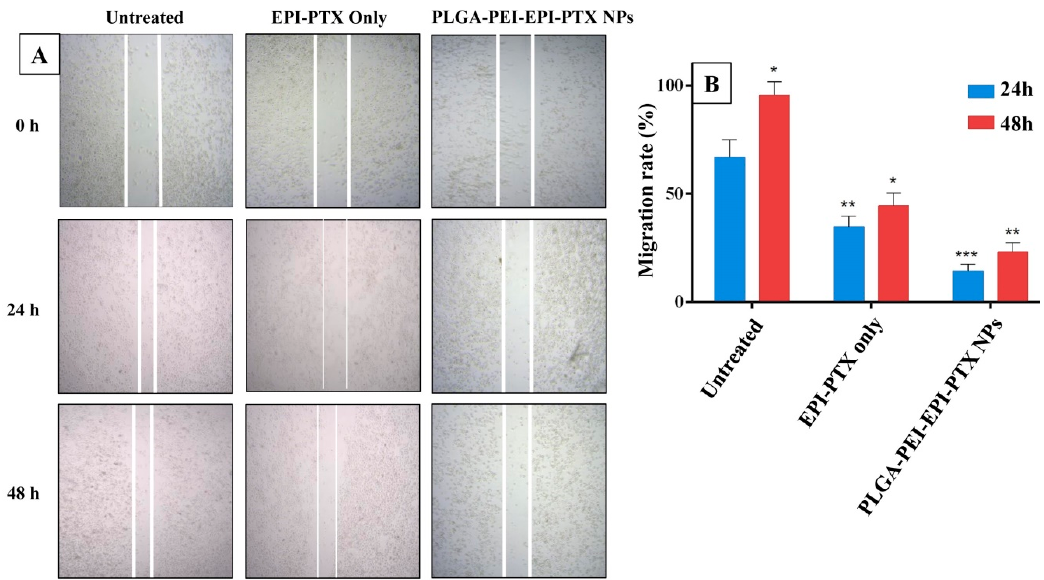
Figure 7. Scratch assay. ( A ) Microscopic images of A549 cells showing reduction of scratch at different time points, and ( B ) Graphical representation of the scratch at 24 h and 48 h. * p < 0.05, ** p < 0.001, *** p < 0.0001.